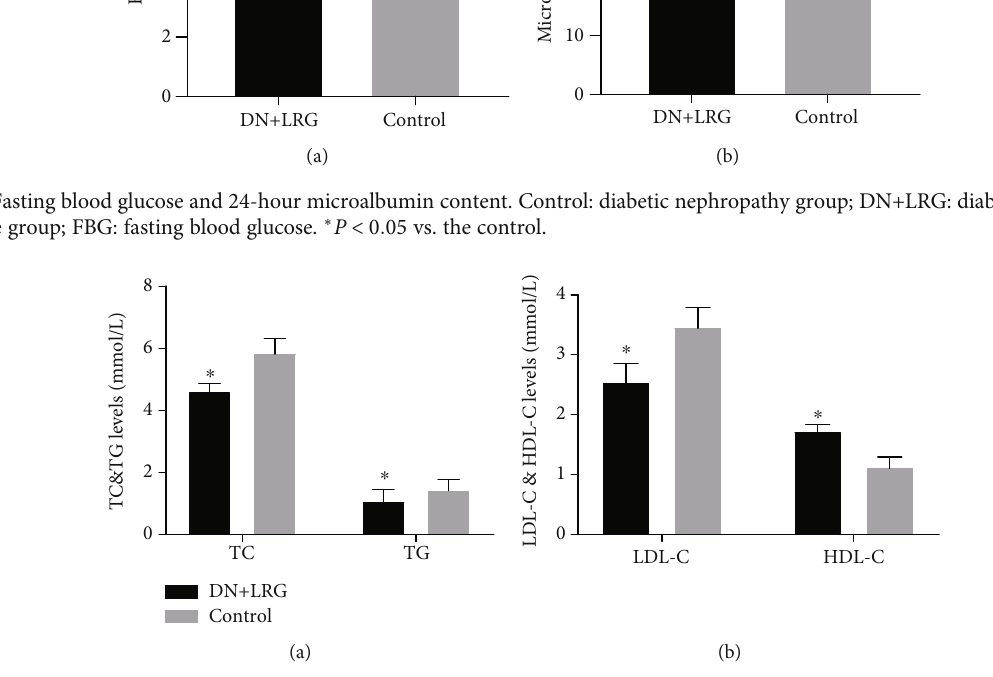
Figure 2: TC, TG, LDL-C, and HDL-C levels. Control: diabetic nephropathy group; DN+LRG: diabetic nephropathy+liraglutide group; TC: total cholesterol; TG: triglyceride; LDL-C: low-density lipoprotein; HDL-C: high-density lipoprotein. ∗ P < 0 : 05 vs. the